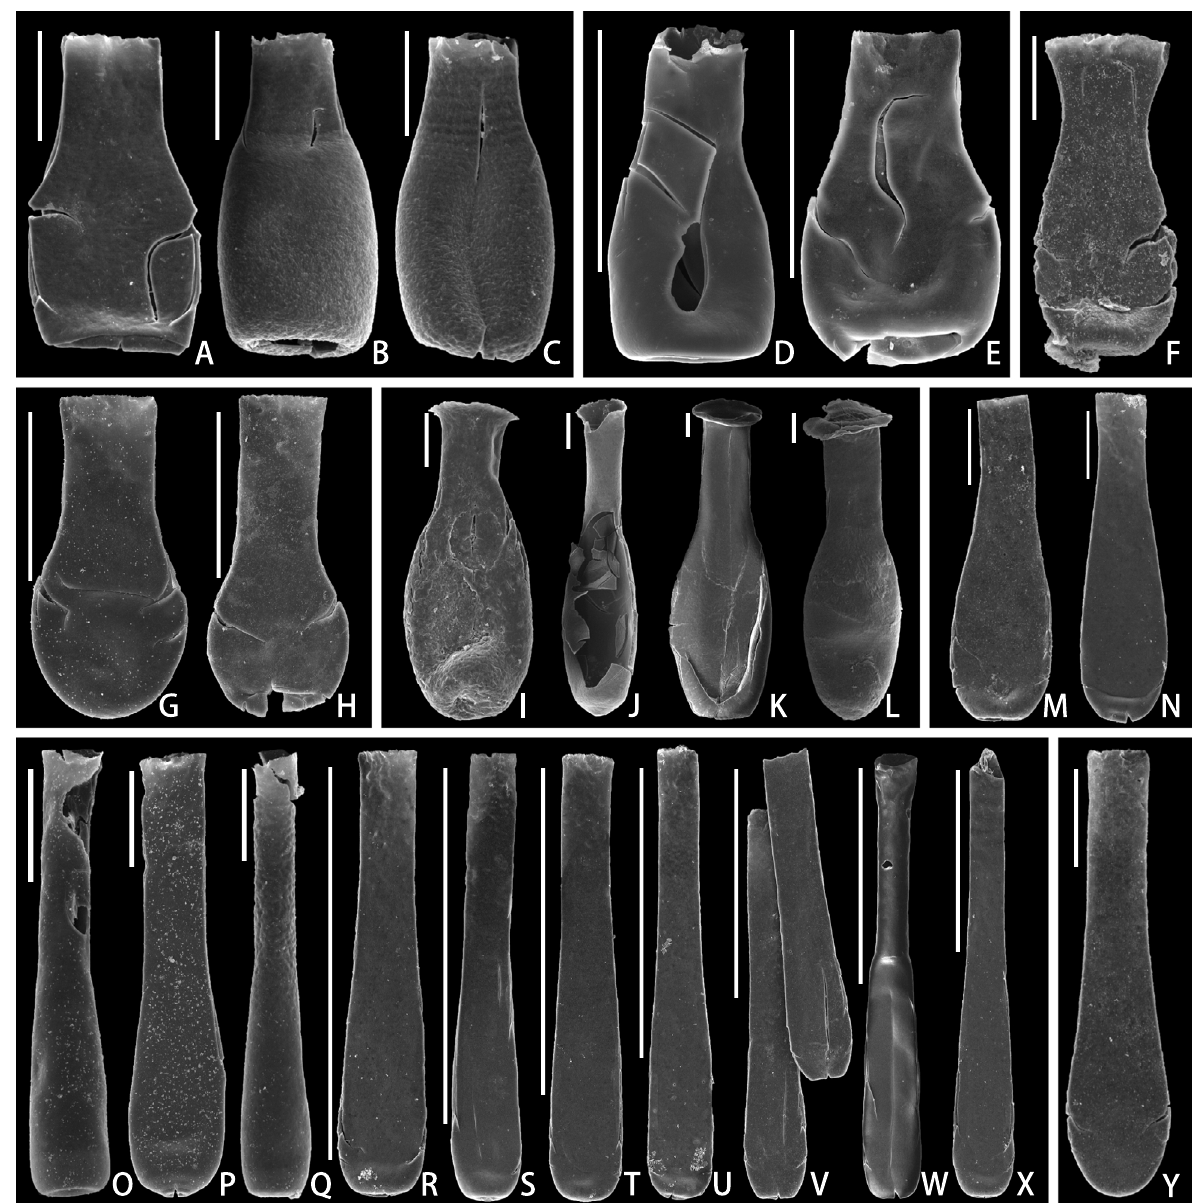
Fig. 3. SEM photos of chitinozoans from the Baldone drill core, central Latvia. The scale bar represents 100 μ m, except in figures R–X where it represents 500 μ m. For sample positions and stratigraphy see Fig. 2. A – C , Lagenochitina combazi ; D , E , Lagenochitina cf. combazi ; F , Lagenochitina sp. 1; G , H , Lagenochitina cf. pestovoensis ; I – L , Lagenochitina megaesthonica ; M , N , Clavachitina langei ; O – X , Conochitina ulsti sp. nov. (T, holotype); Y , Clavachitina grandicula . A, GIT 854-1, sample M-13674; B, GIT 854-2, sample M-13679; C, GIT 854-3, sample M-13674; D, GIT 854-4, sample M-13681; E, GIT 854-5, sample M-13674; F, GIT 854-6, sample M-13675; G, GIT 854-7, sample M-13671; H, GIT 854-8, sample M-13671; I, GIT 854-9, sample M-13674; J, GIT